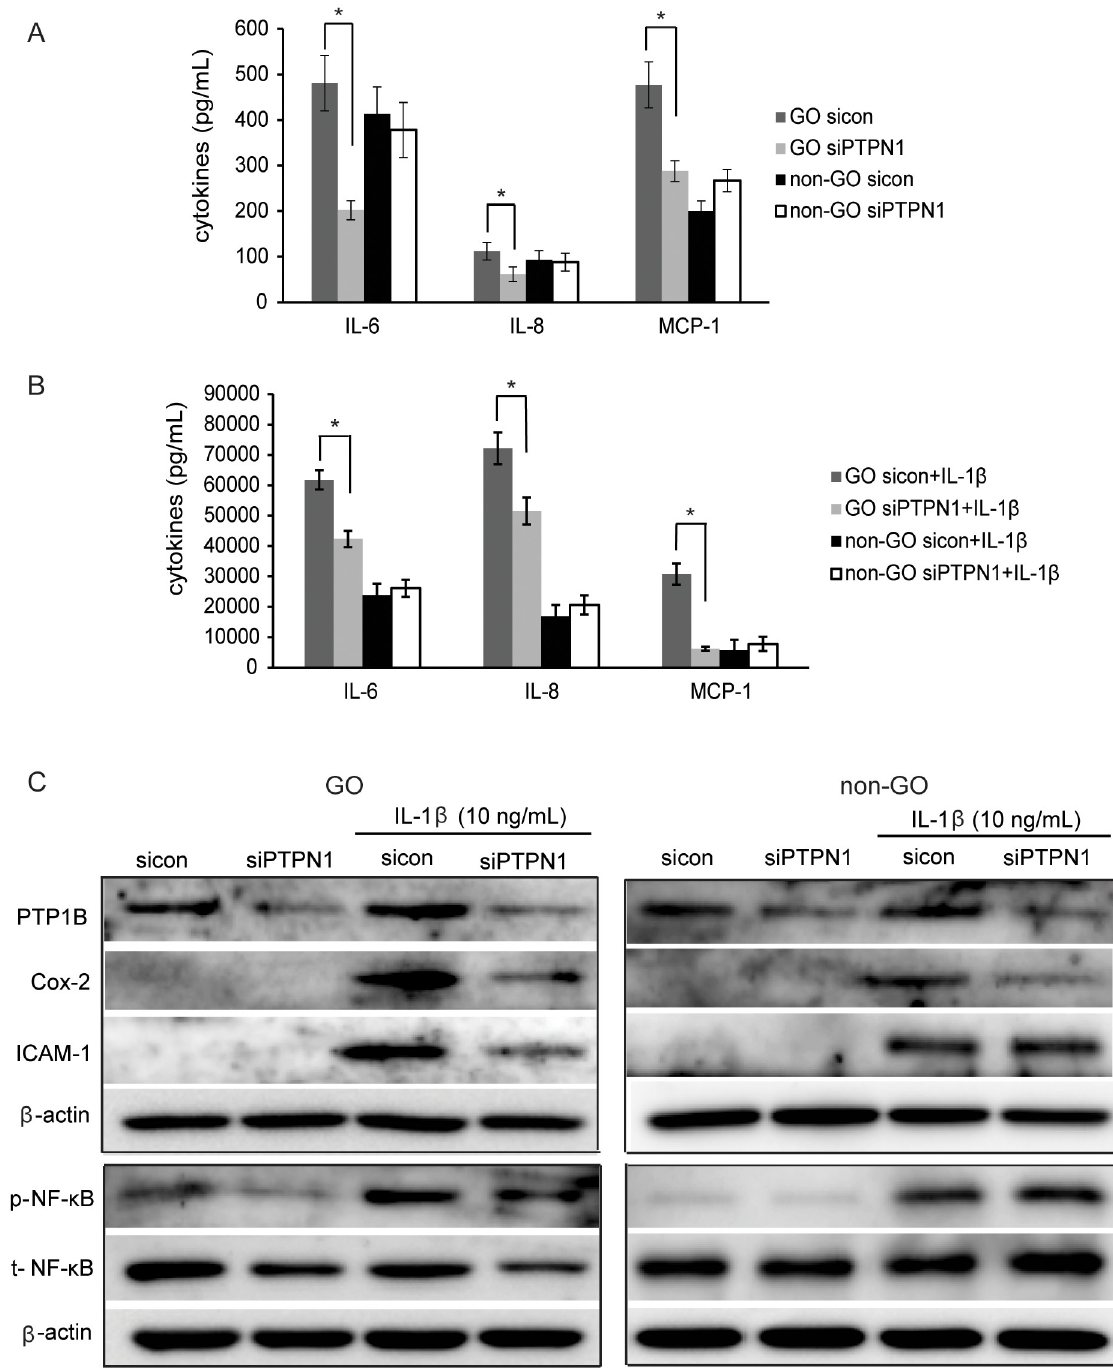
Fig 2. Effect of PTP1B suppression on proinflammatory cytokine production. After transfection of GO and non-GO fibroblasts with siPTPN1 for 24 hours, cells were treated with IL-1 β (10 ng/mL) for 1 hour or 48 hours for the evaluation of NF- κ B or inflammatory cytokine production, respectively. Experiments were performed in three GO and non-GO cells from different individuals. In sicontrol cells and siPTPN1 cells, IL-6, IL-8, and MCP-1 protein release was analysed under basal condition (A) and after 48 hours of IL-1 β (10 ng/mL) stimulation (B) using ELISA ( � p < 0.05, sicontrol versus siPTPN1 cells). (C) Protein expression levels of ICAM-1, Cox-2, and p-NF- κ B in sicontrol and siPTPN1 cells with or without IL-1 β (10 ng/mL) stimulation were evaluated using western blot analysis. Representative bands are shown. See S3 Fig for uncropped